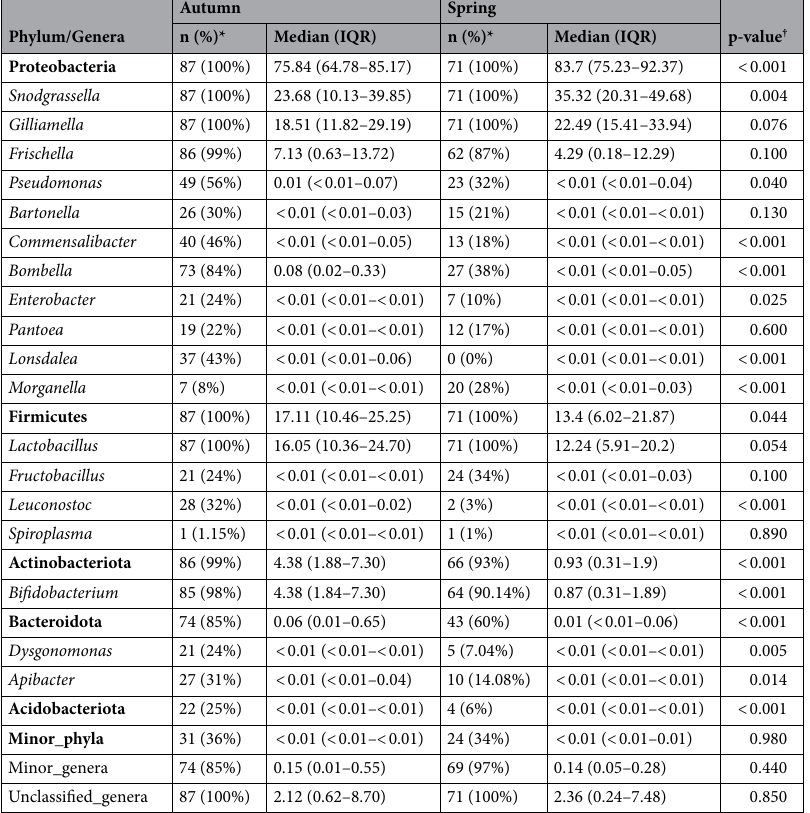
Table 3. Relative frequencies, medians and interquartile range (IQR) of the most abundant bacterial phyla (bold) and genera (italics) detected in the AS of bees collected in autumn and spring. *Number of samples in which the phylum/genus was detected (relative frequency of detection). † Wilcoxon rank sum test with Bonferroni